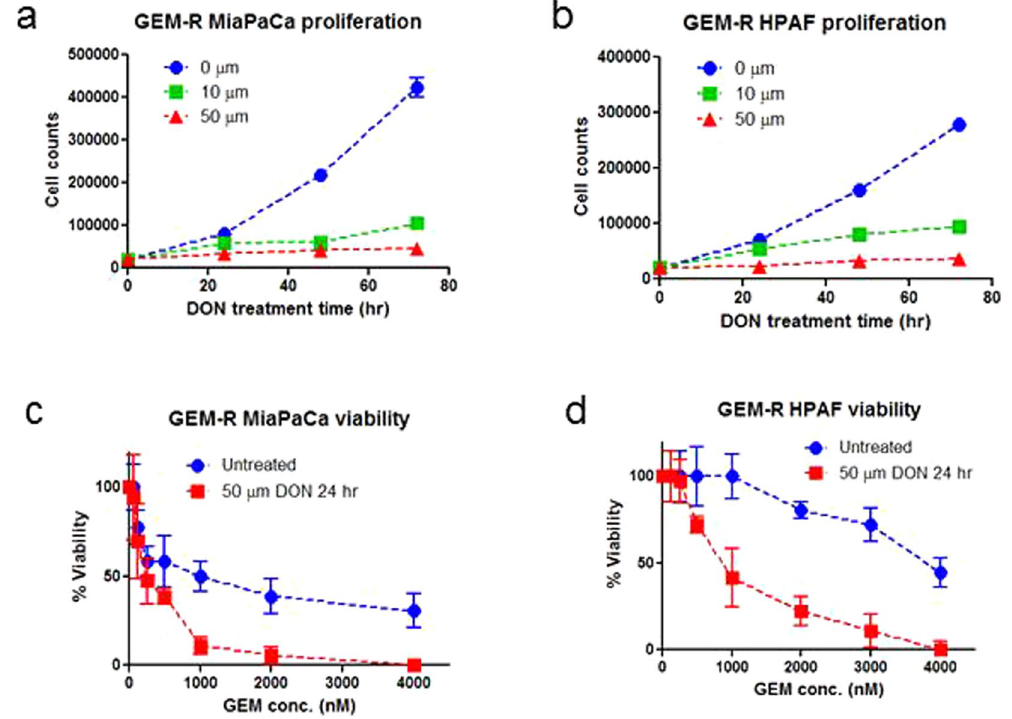
Figure 2. DON treatment of GEM-R pancreatic cancer cells significantly reduced cell proliferation and enhanced chemosensitivity. ( a ) Cell proliferation curves of GEM-R MiaPaCa treated with different concentrations of DON. ( b ) Cell proliferation curves of GEM-R HPAF II treated with different concentration of DON. ( c ) GEM-R MiaPaCa cells treated with 50 µ m of DON for 24 hours showed significantly enhanced GEM efficacy. The IC 50 value decreased 4 fold. ( d ) GEM-R HPAF II cells treated with 50 µ m of DON for 24 hours showed significantly enhanced GEM efficacy. The IC 50 value decreased 4